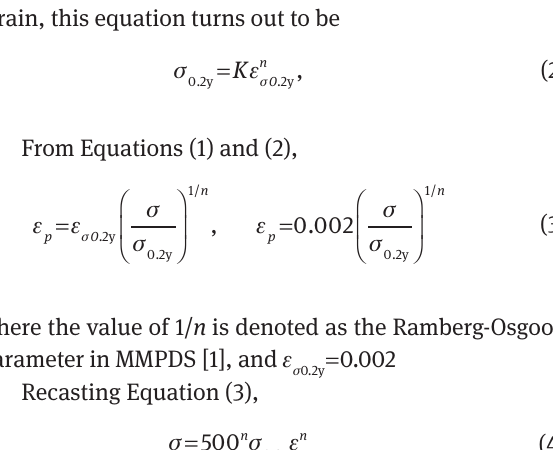
Figure 2 Variation of strain hardening exponent as a function of the ratio of engineering ultimate tensile strength to true yield